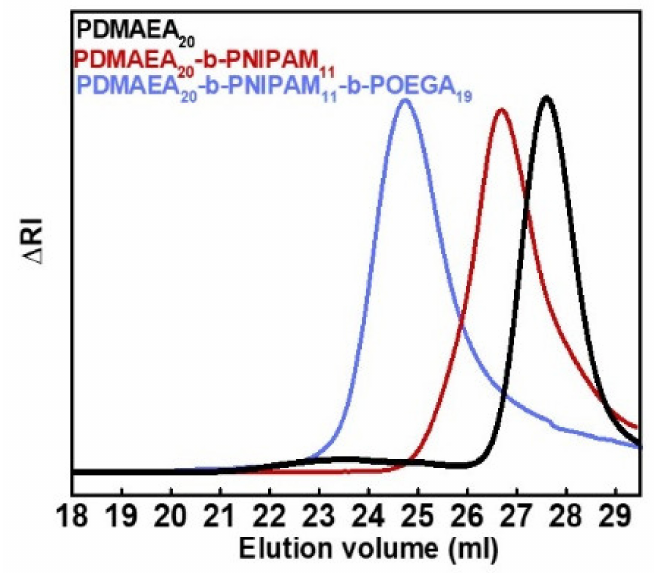
Figure 1. Size exclusion chromatography (SEC) traces of PDMAEA 20 homopolymer, PDMAEA 20 -b- PNIPAM 11 diblock copolymer, and PDMAEA 20 -b-PNIPAM 11 -POEGA 18 triblock terpolymer in tetrahydrofuran (THF, containing 5% Et 3